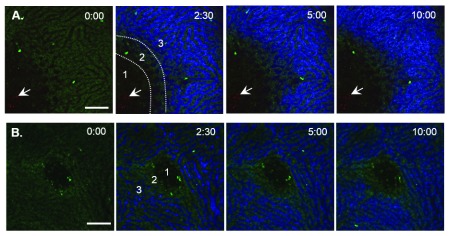
Lack of perfusion of LM foci.
A and
B, CB6F1 animals were imaged at day 3 post-infection with 2 x 10
4 LM-RFP (red) and eGFP-L9.6 transgenic T cells (green). Mice were injected with 10 kDa Alexa-647 (blue) i.v. while imaging. Three distinct regions are identifiable; foci proper (1), foci border (2) and perfused normal liver parenchyma (3).
A, large foci with LM-RFP.
B, small foci lacking visible LM-RFP is likely the top of a deeper focus. Scale Bar = 100 μm.